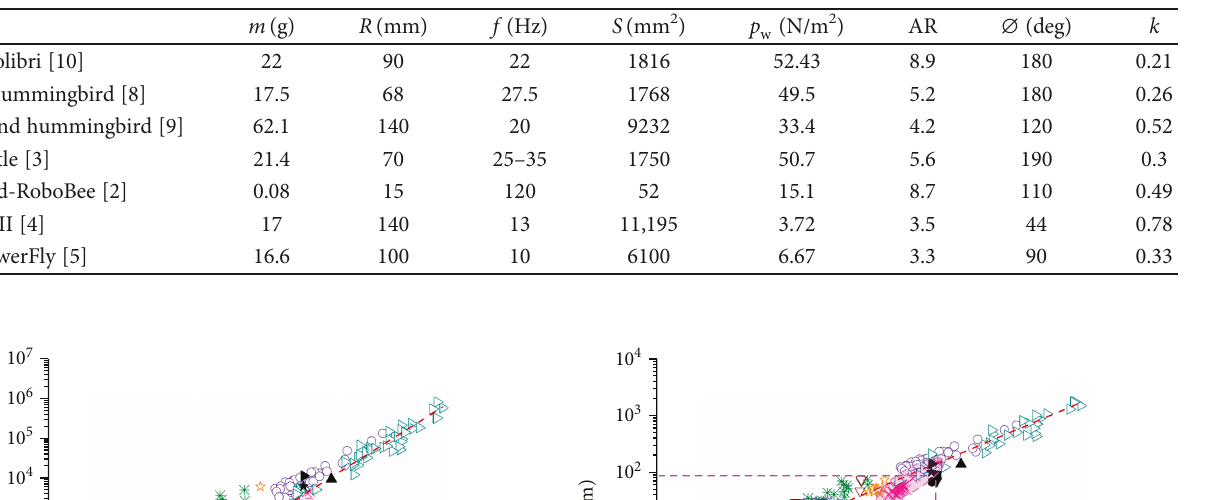
Table 4: Parameters of existing fl apping wing MAVs.